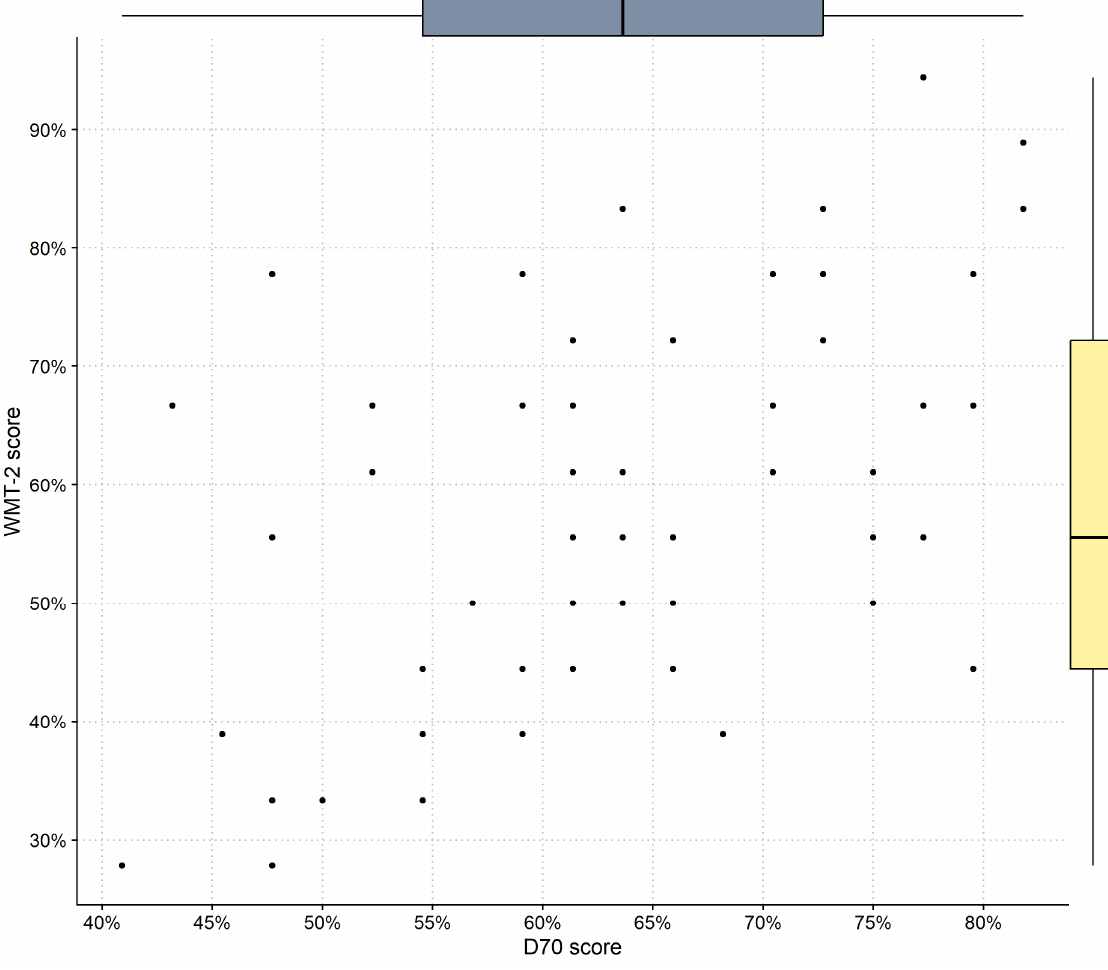
Figure 2. Scatter plot with box plots on the margin for the behavioral variables used in Study 1. The dots indicate the given test score of each participant, and the box plots present the data distribution for each